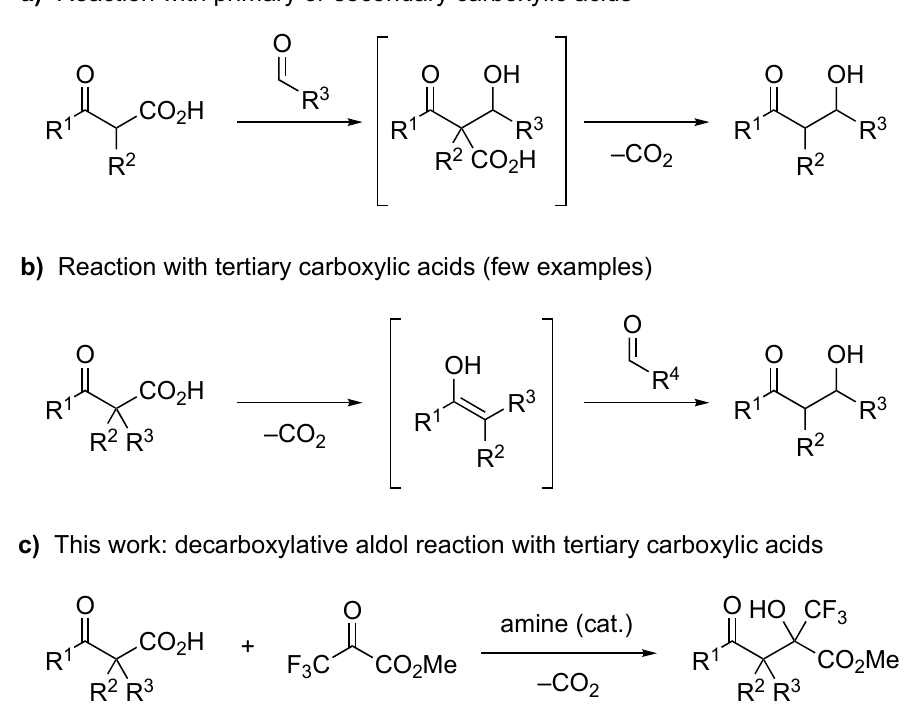
Figure 1. Decarboxylative aldol reactions of β -oxocarboxylic acids: ( a ) Reaction with primary and secondary carboxylic acids; ( b ) Reaction with tertiary carboxylic acids; ( c ) This work.